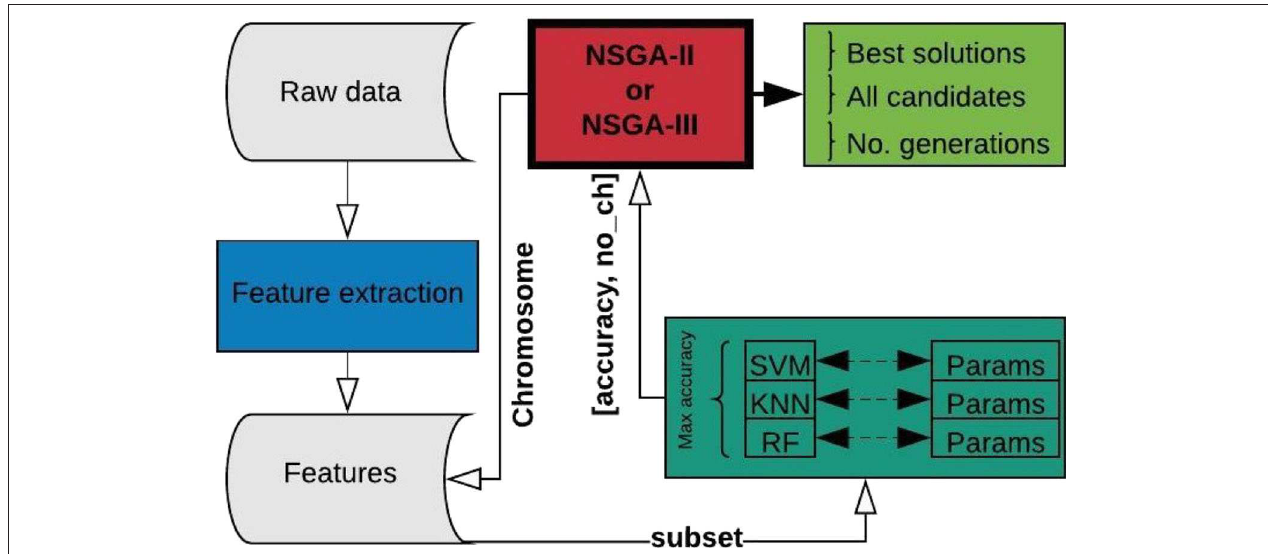
FIGURE 2 | Complete process for EEG channel selection using NSGA-II or NSGA-III.